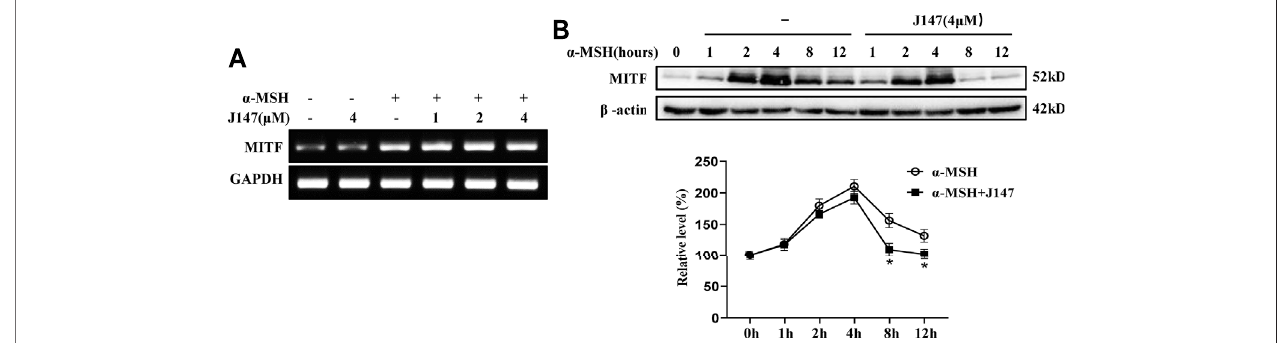
FIGURE4| EffectofJ147ontheexpressionofMITFinB16F10cells. (A) B16F10cellsweretreatedwith α -MSH(60 nM)inthepresenceorabsenceofJ147for4 h andRT-PCRwasthenappliedtodetectMITFgeneexpression. (B) B16F10cellsweretreatedwith α -MSH(60 nM)inthepresenceorabsenceofJ147fordifferenttimes andwesternblotwasthenappliedtodetectMITFproteinlevels.Dataareexpressedasthemean ± SD( n (cid:2) 3).* p < 0.05vs. α